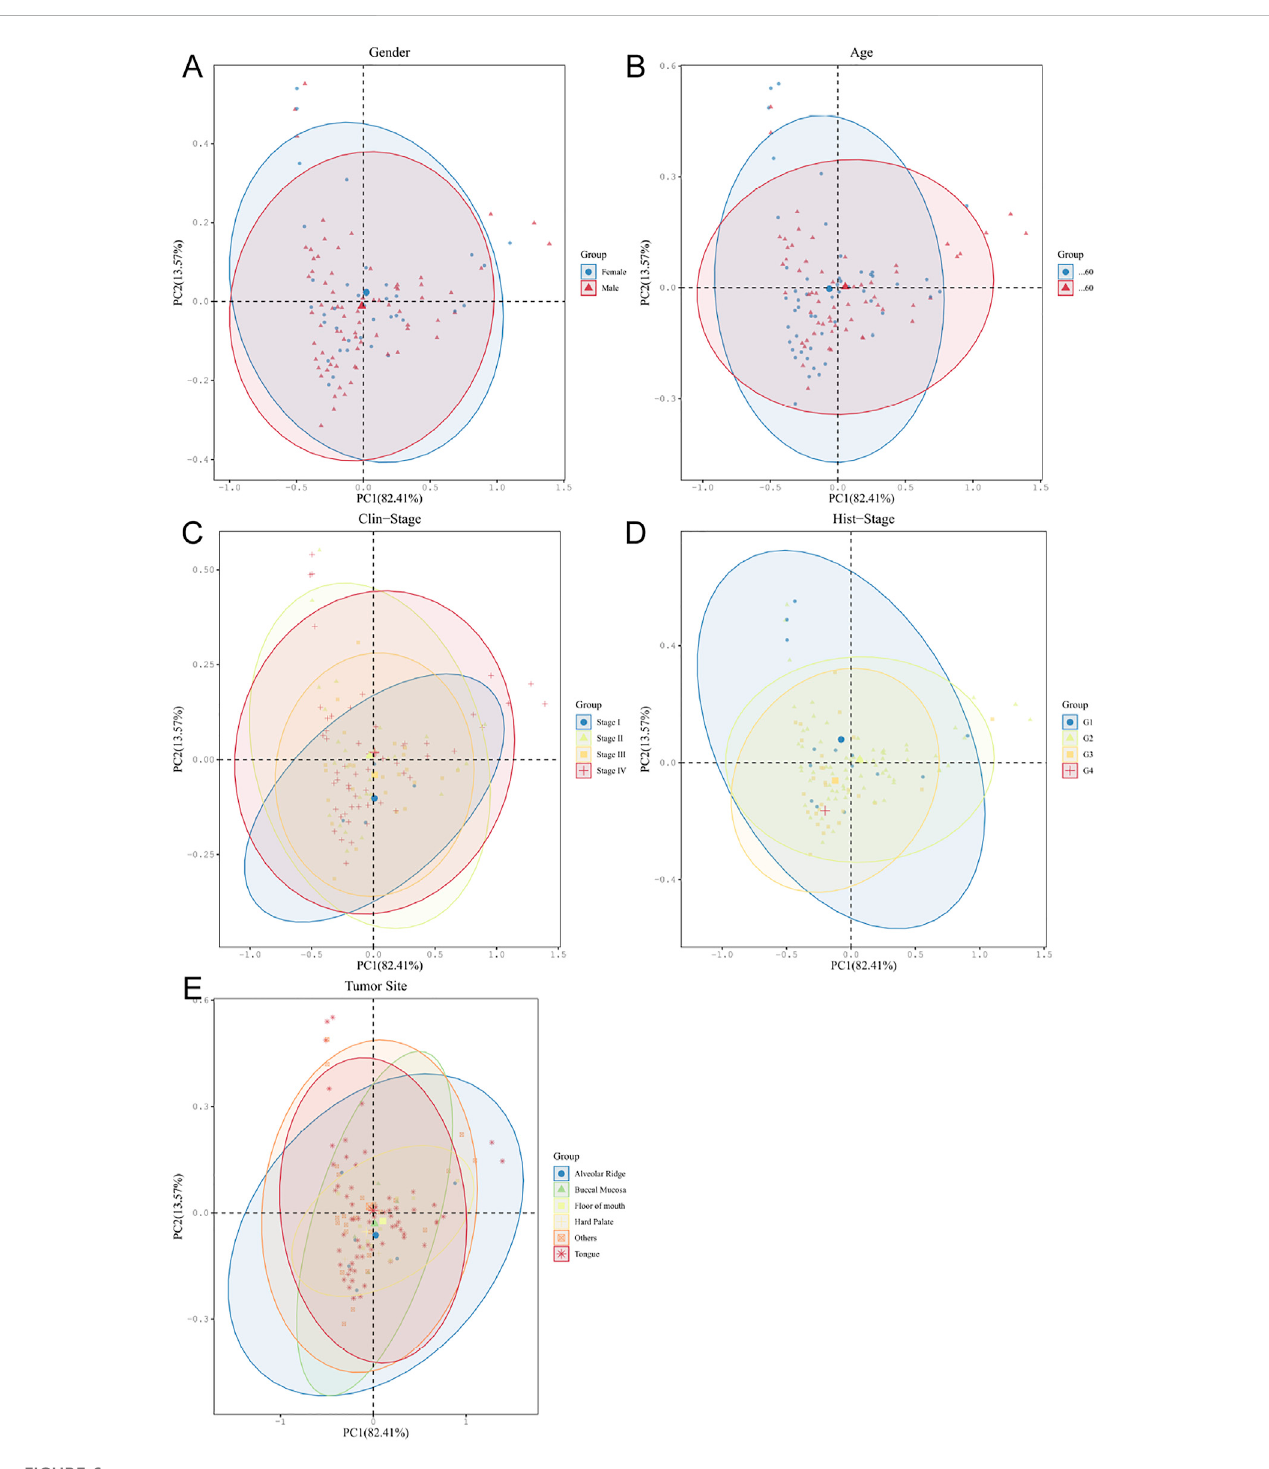
FIGURE 6 Oral microbiota analyses of OSCC tumors based on different clinical parameter subgroups (A – E)